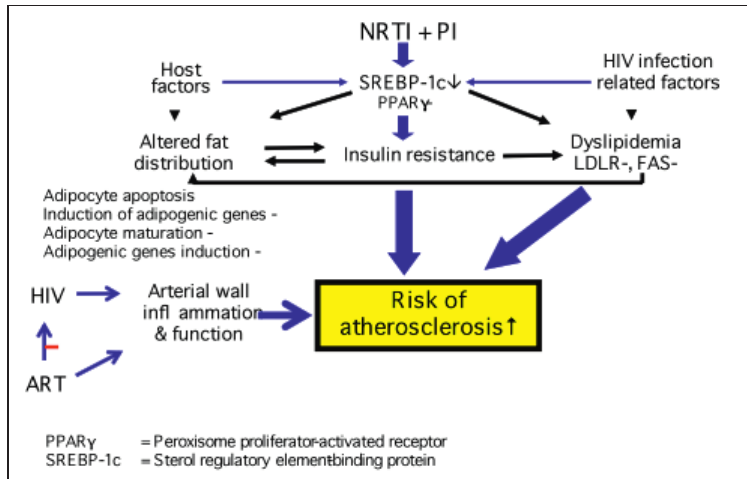
The pathogenesis of lipid disorders is multifactorial, involving effects of antiretroviral treatment, HIV itself and genetic and other host